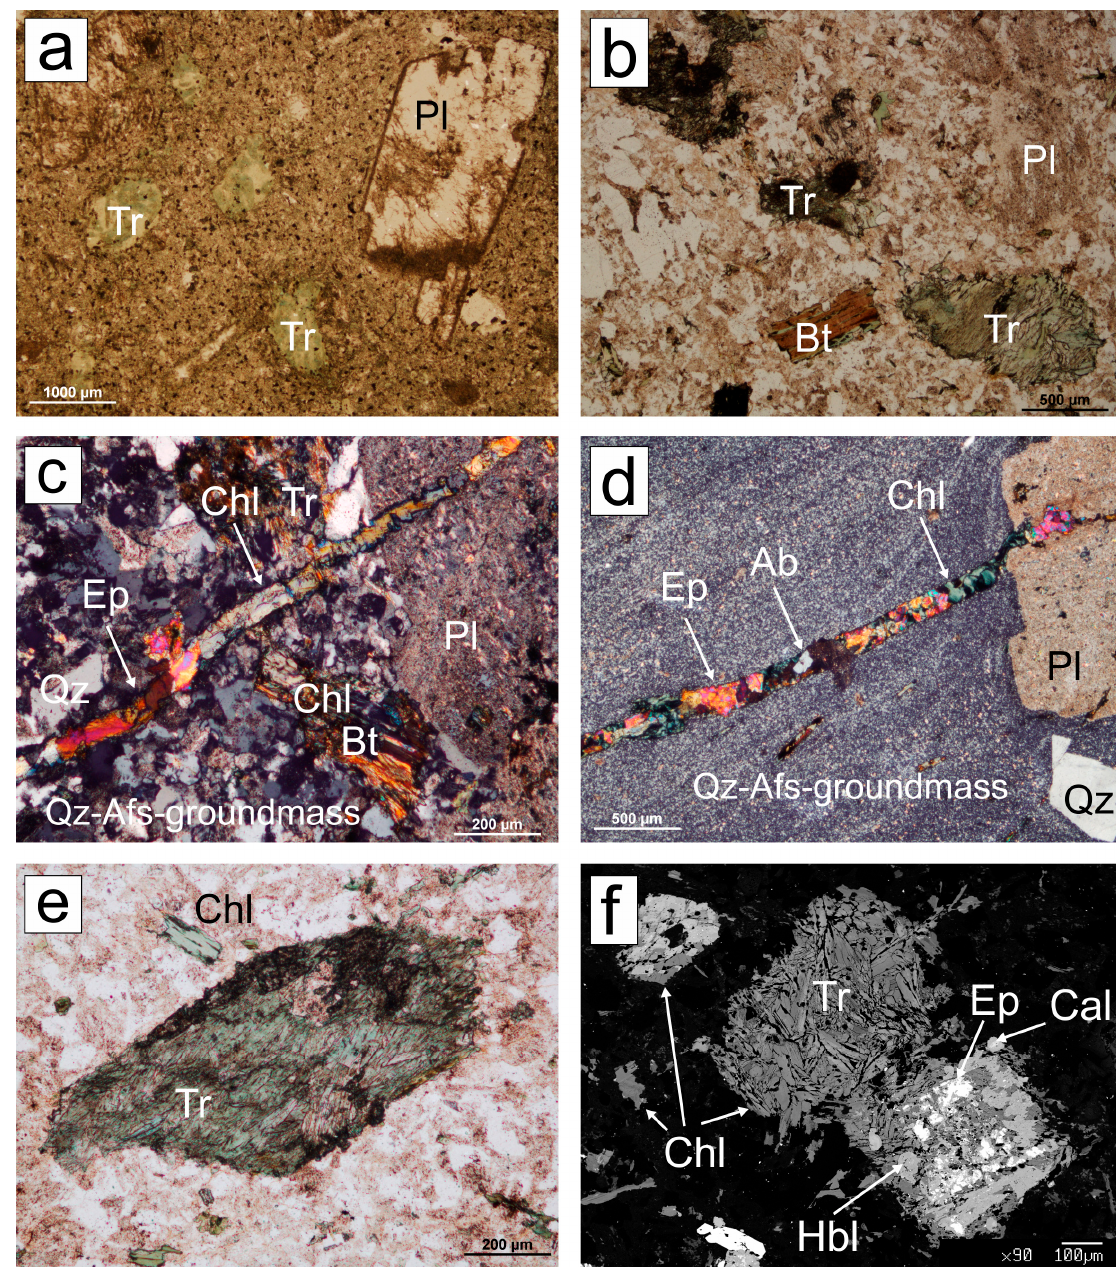
Figure 6. Thin section and back-scattered electron (BSE) images of the Isadalu magmatic rocks: ( a ) albitized plagioclase and hornblende with pseudomorph textures in mafic oligophyric dykes; ( b ) albitized plagioclase, chloritized biotite and hornblende with pseudomorph texture in porphyritic felsic rock; ( c , d ) Isadalu felsic rocks showing holocrystalline meso- to micro-crystalline textures and isotropic to fluidal fabrics; Chl + Ep veinlets are commonly observed in felsic rocks; ( e ) PLM image showing acicular amphibole pseudomorphosis on primary hornblende; ( f ) BSE image showing secondary assemblage (Tr + Chl + Ep + Cal) pseudomorphosis on Hbl + Pl. Felsic rocks from the main Isadalu complex body (i.e., Sierra Isadalu) are represented by porphyritic hypabyssal pink plutonic rocks crossed by gray to pink extrusive/subvolcanic